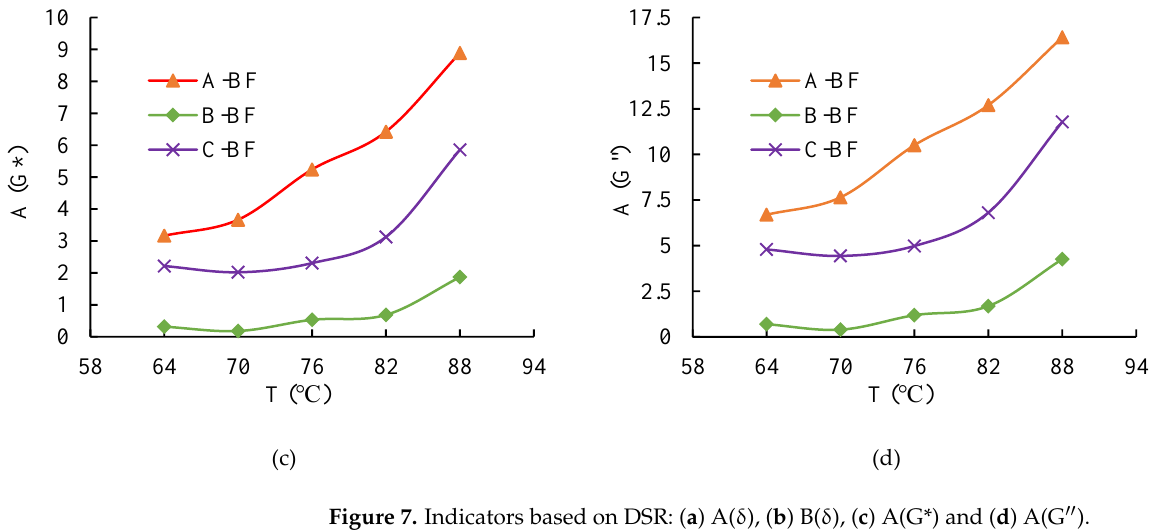
Figure 7. Indicators based on DSR: ( a ) A(δ), ( b ) B(δ), ( c ) A(G*) and ( d ) A(G’’) .